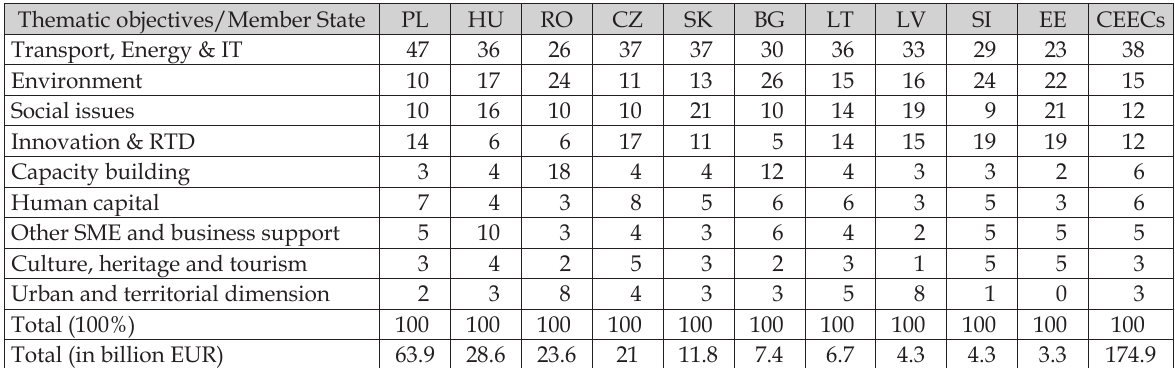
Table 1. The structure of Cohesion policy budget by thematic objectives in CEECs 2007–2013 (% from budget of Member States allocated to selected aims, based on annual implementation report